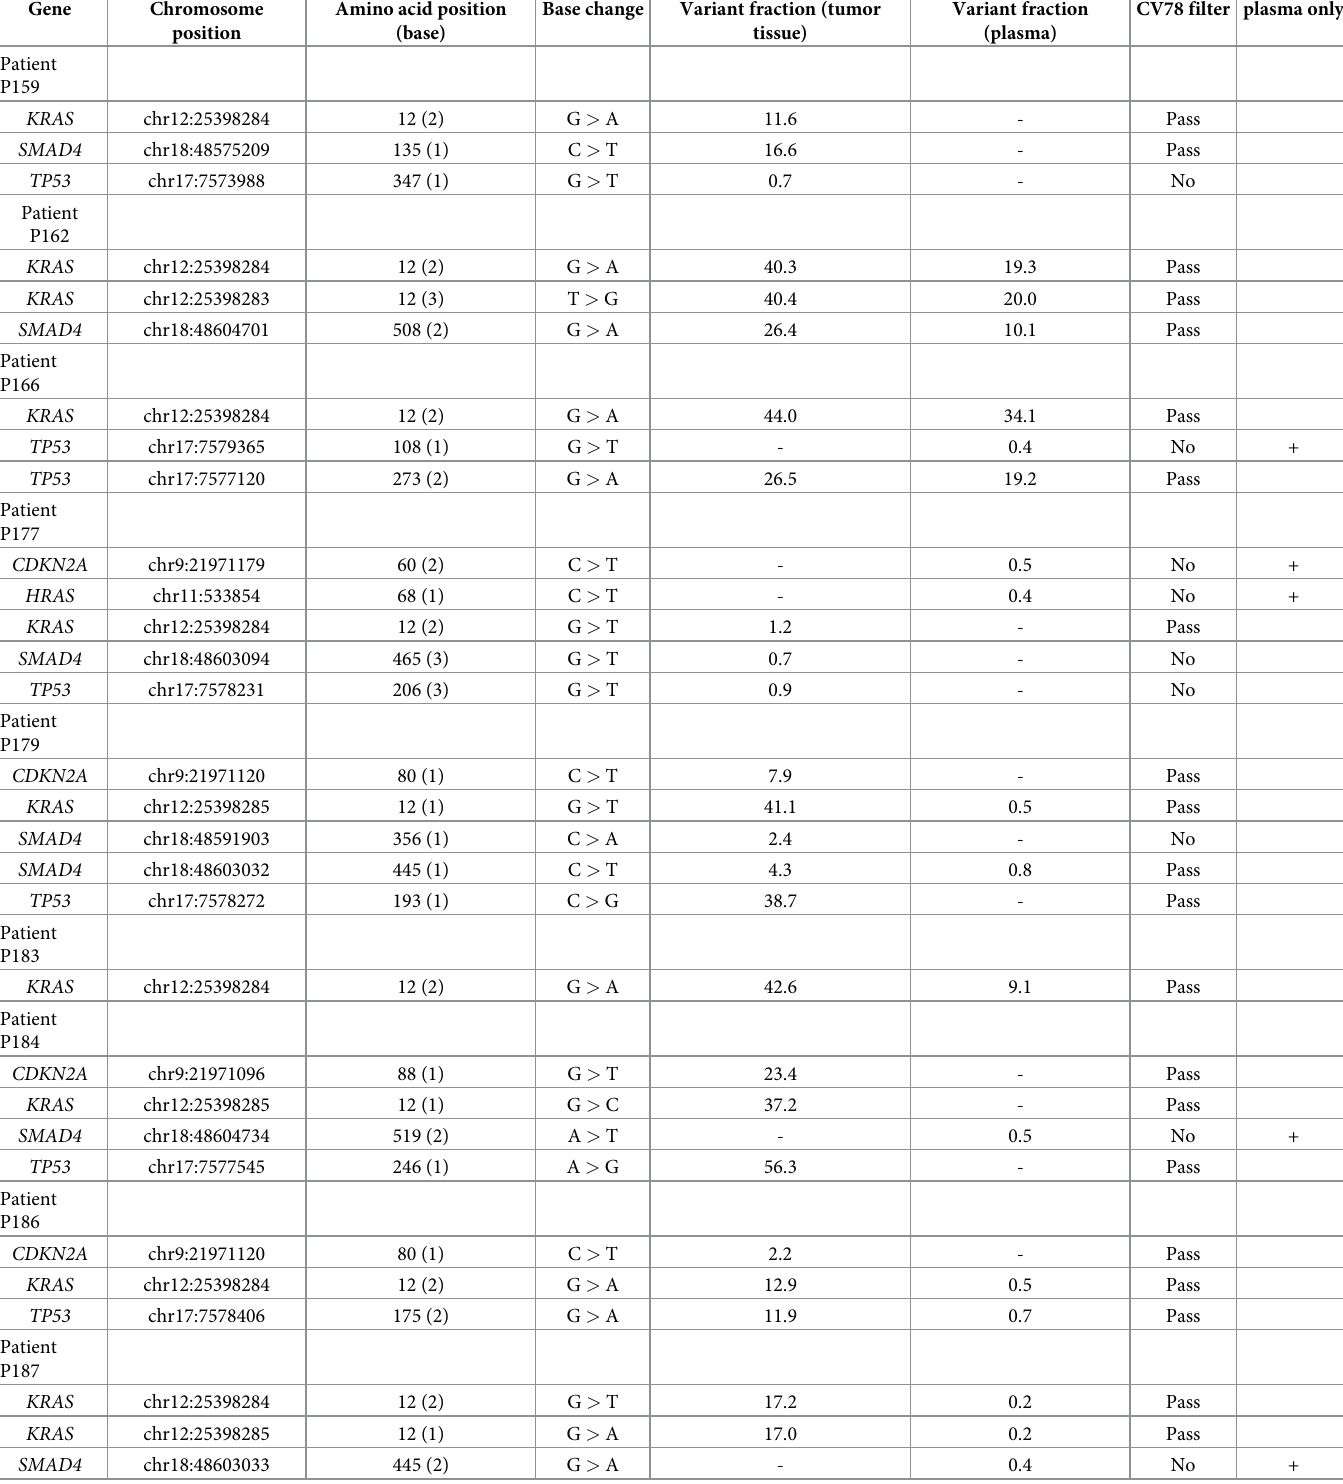
Table 2. Comparison of variants detected in plasma and tumor tissue from 10 patients with pancreatic cancer. Gene Chromosome Amino acid position position